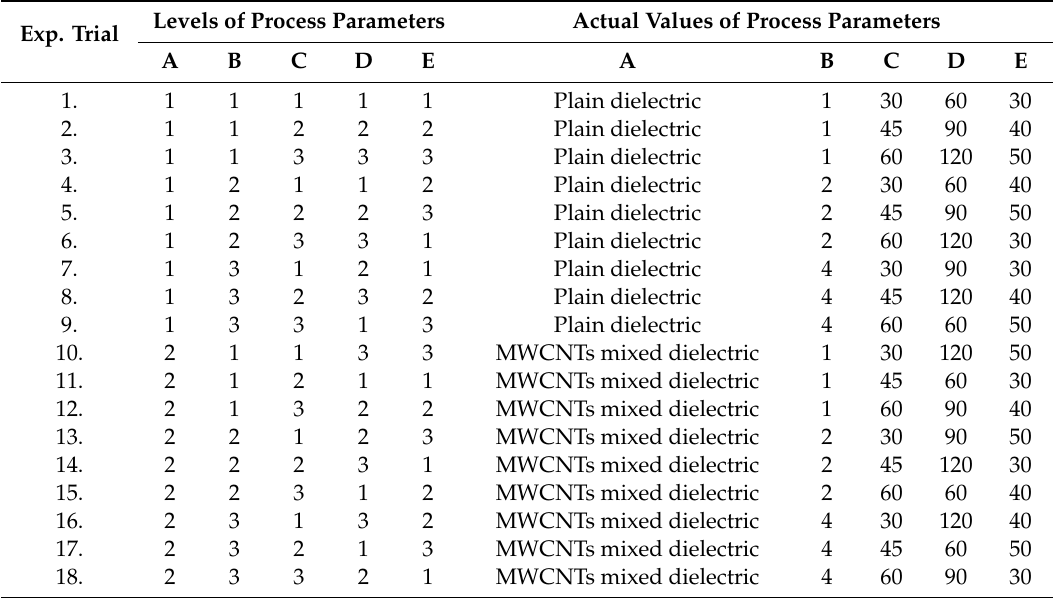
Table 4. Taguchi’s L18 experimental design